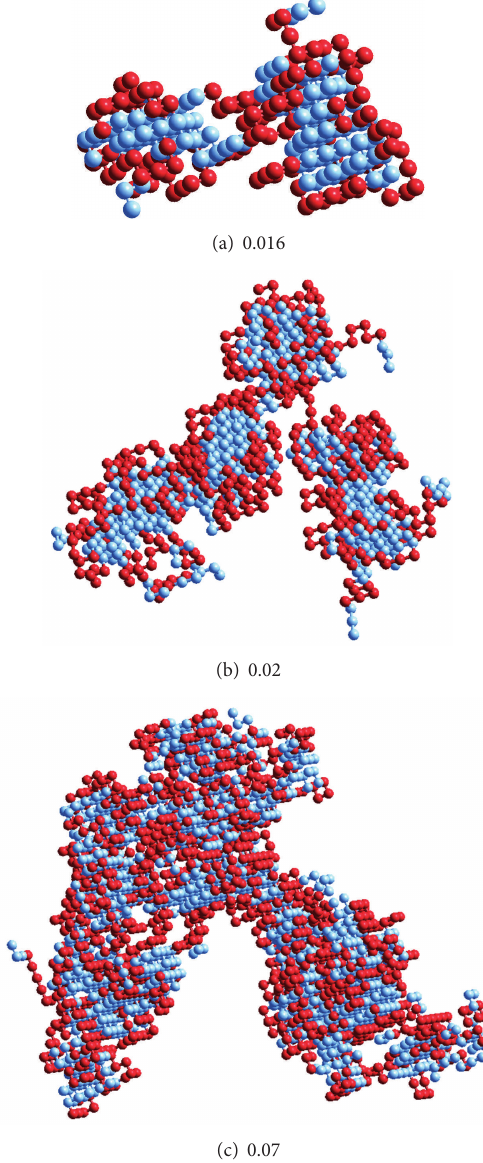
at volume fractions of 2